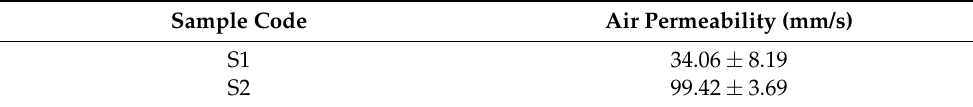
Table 6. Results of air